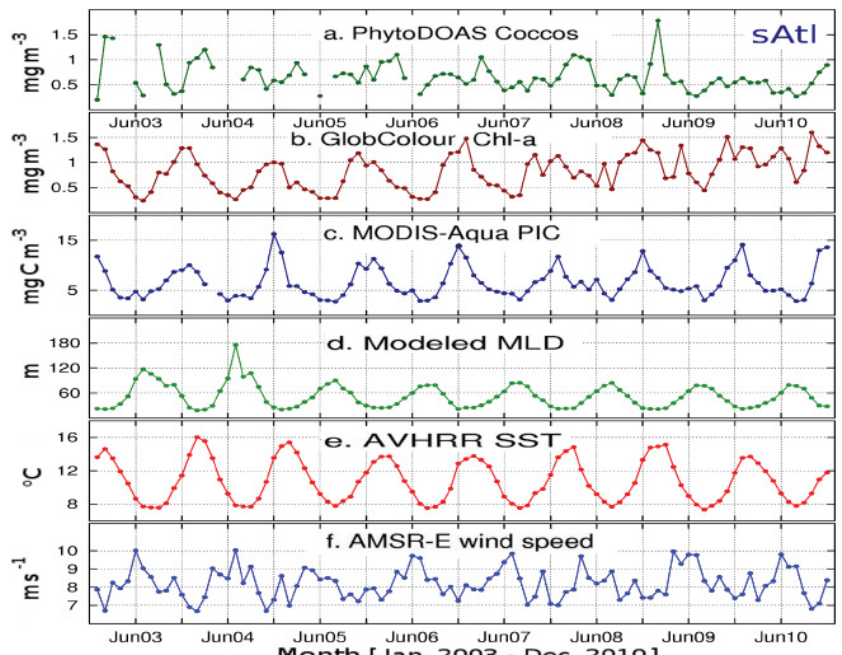
Fig. 4. Time series as described in Fig. 3, but for the sAtl